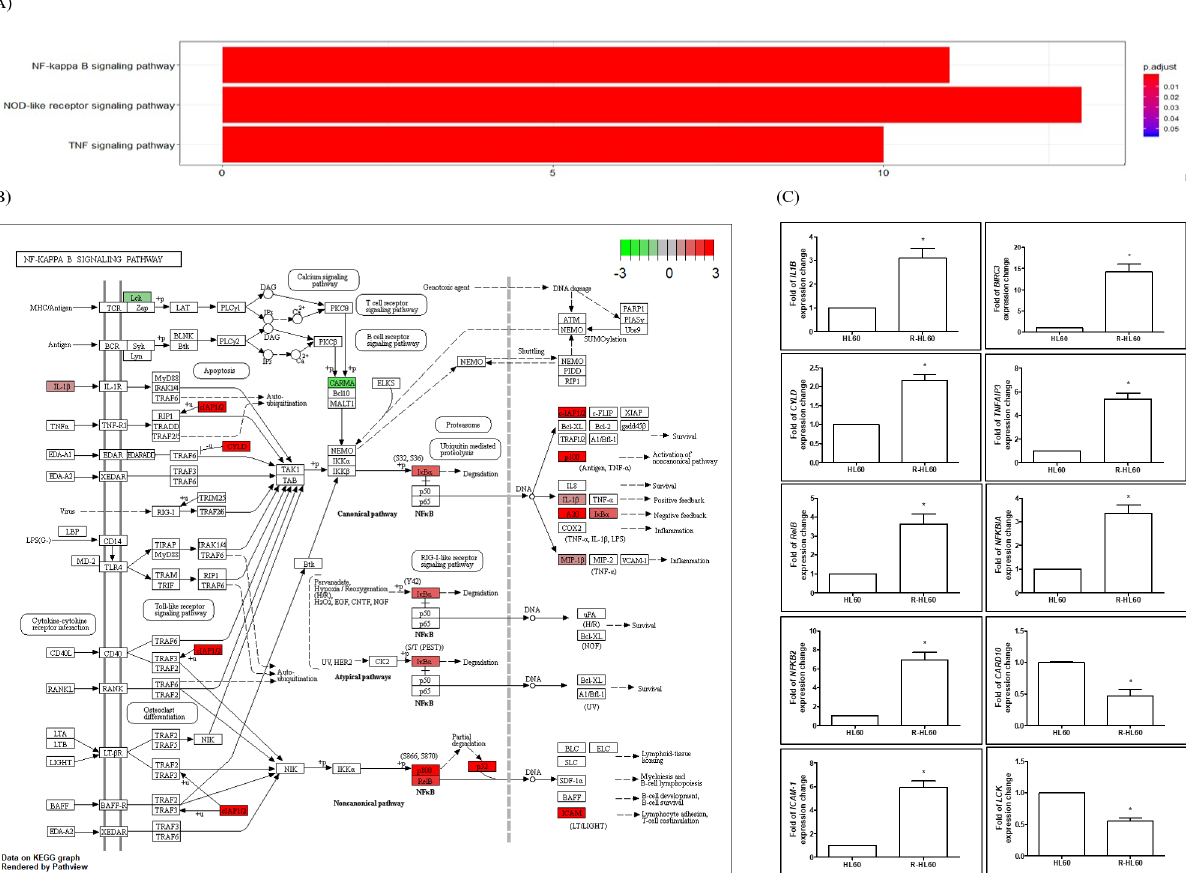
Figure 2. Nuclear factor κ B (NF- κ B) pathway is the top signaling pathway with the most DEGs during the development of R-HL60 cells. ( A ) Changes in signaling pathways during the development of parental HL60 cells into cytarabine-resistant HL60 cells were measured through KEGG pathway enrichment analysis. According to the adjusted p value, the greatest changes were observed in the NF- κ B signaling pathway. ( B ) Map of the NF- κ B signaling pathway with the lowest p. adjust (2.64 × 10 − 6 ). The expression of 11 genes ( IL1B , CYLD , RELB , CCL4L2 , NFKB2 , ICAM1 , BIRC3 , TNFAIP3 , NFKBIA , CARD10 , and LCK ) involved in this pathway changed significantly. The upward and downward thermometers marked in red and green indicate upregulated and downregulated signals, respectively. The solid line represents direct action, and the dashed line represents indirect action. ( C ) Gene expression was validated using real-time PCR analysis, the results of which were largely consistent with the results of the gene expression array. The expression of CCL4L2 could not be detected because of limitations of real-time PCR analysis. The paired t -test was applied to determine the differences between HL60 and R-HL60 cells. The data are represented as the mean ± standard error of three independent experiments, with * p < 0.05 indicating a statistically significant difference. A20 (encoded by TNFAIP3); I κ B α (encoded by NFKBIA); NFKB2 (encoded by p52 and p100); CARD10 (encoded by CARMA3); cIAP2 (encoded by